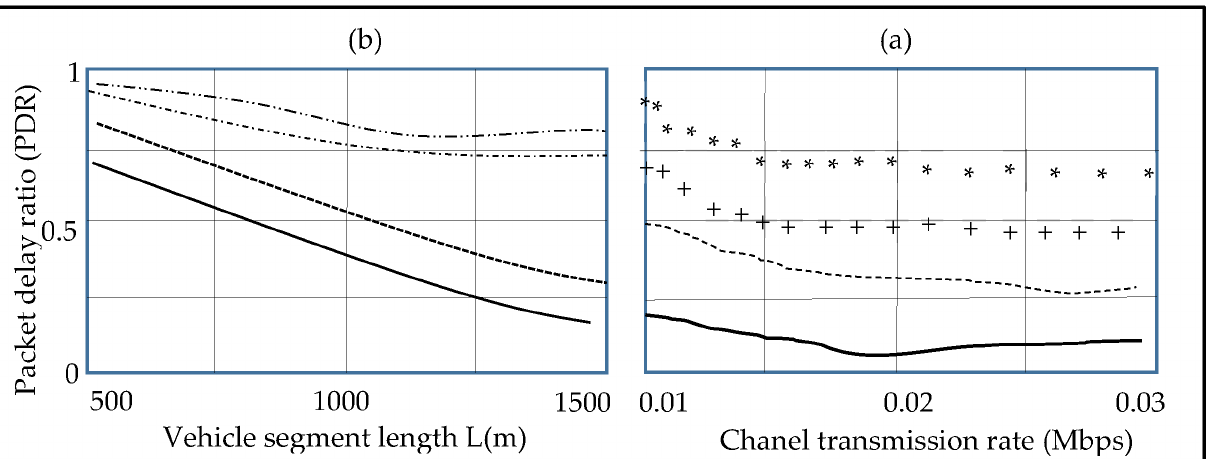
Figure 5. Road segment packet delay in the transmission channel. ( a , b ) depict the relationship between the road section delay, cell size, CTR, and the spacing density of the UGV. Once the simulation and the analytical results concur well for cs = 0.75 R, the precision of our road segment delay model is demonstrated. Additionally, from Figure 5a it shows that, when the vehicle spacing density grows, the road segment latency decreases significantly, demonstrating that the network partitions may be corrected. In Figure 5b, the “λ” is set to (0.03) vehicles/m. The figure illustrates how the latency of the road seg- ments reduces as the CTR improves, allowing the packets to communicate swiftly with no need for consuming time. Based on the previous study, in the case of cs = 0.75 R, the whole error average for the simulation and the analytical findings are not more than 5%, demonstrating that, the